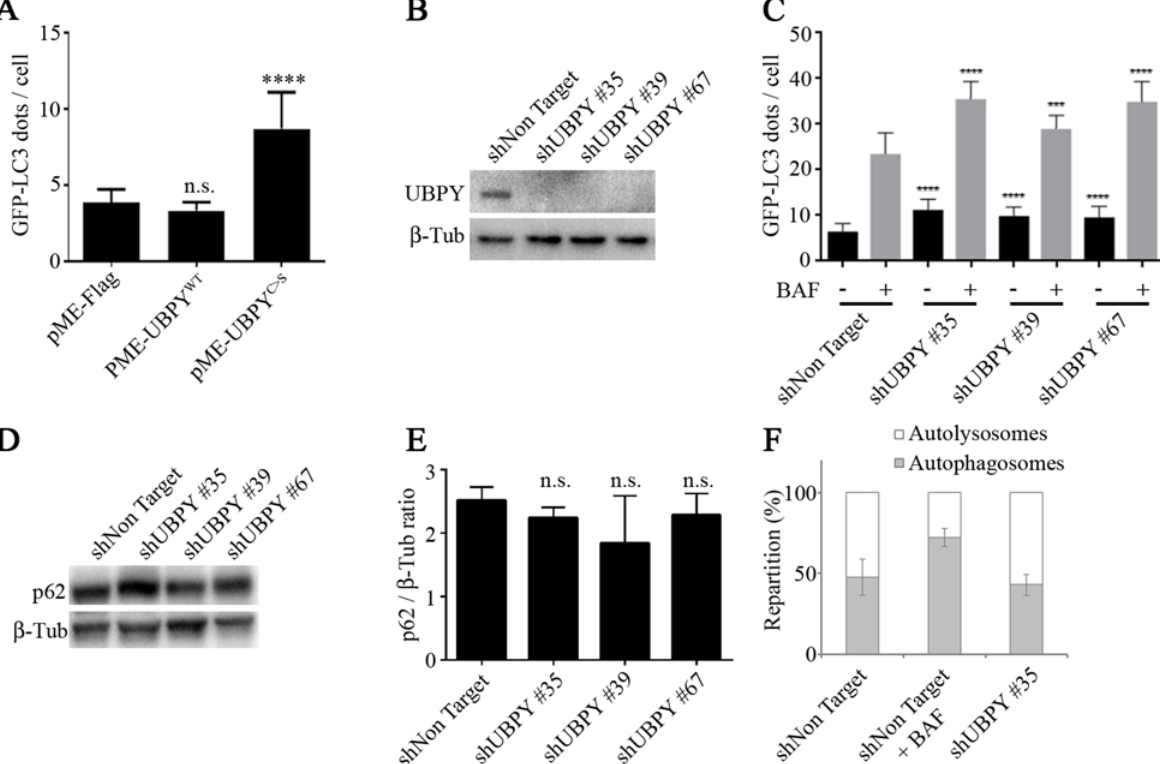
Fig 6. UBPY silencing in HeLa cells activates autophagy. (A) The number of GFP-LC3 dots per cell was quantified in HeLa cells stably expressing the autophagy reporter GFP-LC3; cells were transfected with a control plasmid (pME-Flag) or plasmids expressing either the wild-type human UBPY protein (pME-UBPY WT ) or its catalytically inactive mutant (pME-UBPY C > S ). Bars denote mean ± s.d. Statistical significance was determined using t-test : **** p < 0.0001 (B) The expression of UBPY was monitored by Western blot in GFP-LC3 HeLa cells stably transfected with a control shRNA or three different shRNAs targeting UBPY. (C) The number of GFP-LC3 dots per cell was quantified in GFP-LC3 HeLa cells stably transfected with a control shRNA or three different shRNAs targeting UBPY in absence (black bars) or in presence of bafilomycin A1 (BAF, gray bars). Bars denote mean ± s.d. Statistical significance was determined using t-test : **** p < 0.0001; *** p < 0.005 (D) The expression of the autophagy target protein p62 was monitored by Western blot in GFP-LC3 HeLa cells stably transfected with a control shRNA or three different shRNAs targeting UBPY. (E) Quantification of p62 levels in GFP-LC3 HeLa cells stably transfected with a control shRNA or three different shRNAs targeting UBPY from three independent Western blots. (F) The repartition of autolysosmes and autophagosomes was determined in mRFP-GFP-LC3 HeLa cells stably expressing either the control shRNA or the shUBPY #35 shRNA, in comparison with control transfected cells treated with bafilomycin